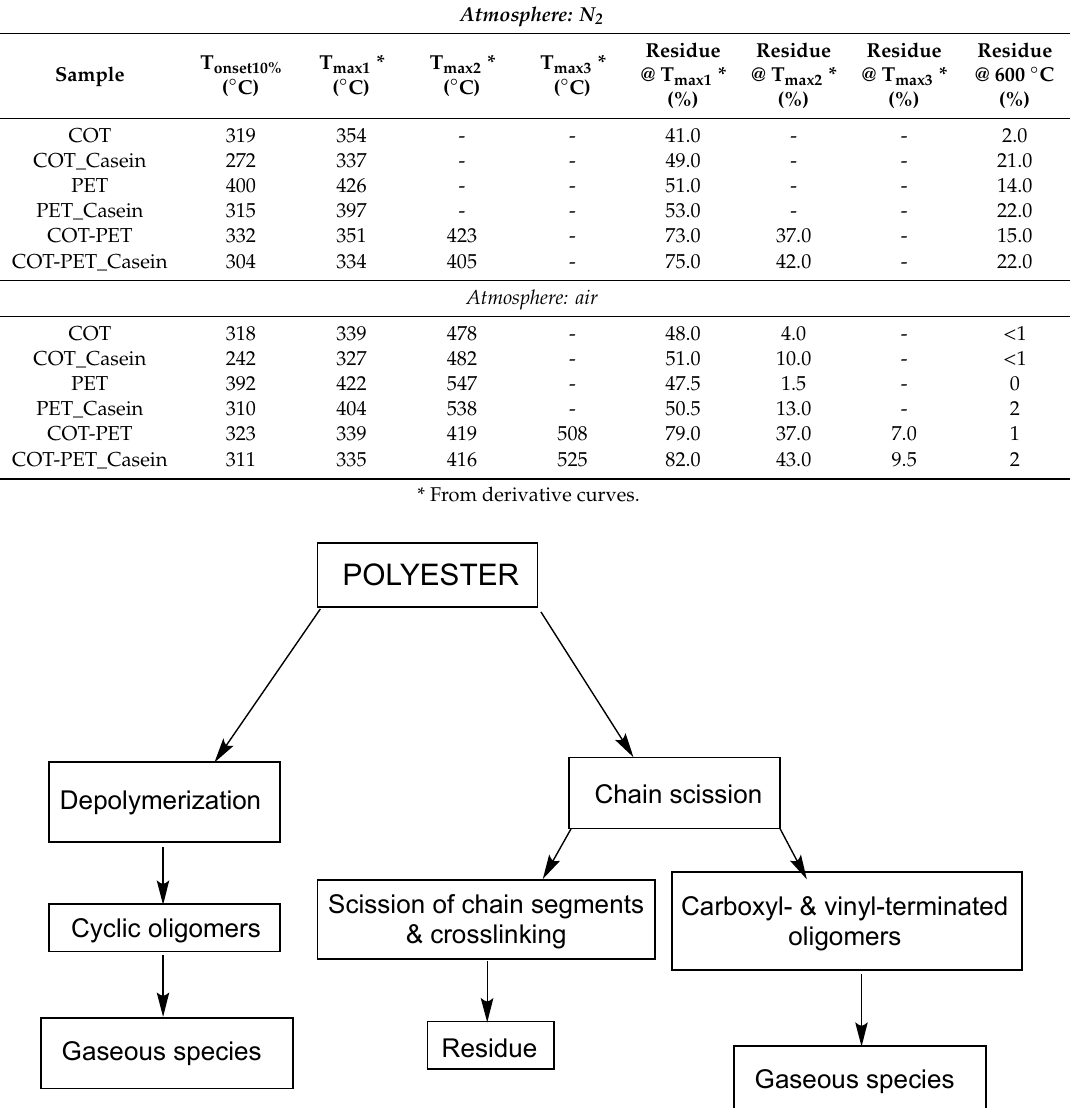
Table 4. Results for untreated and caseins-treated fabrics from horizontal flame spread tests. Table 3. Thermal and thermo-oxidative stability of the untreated and treated fabrics.